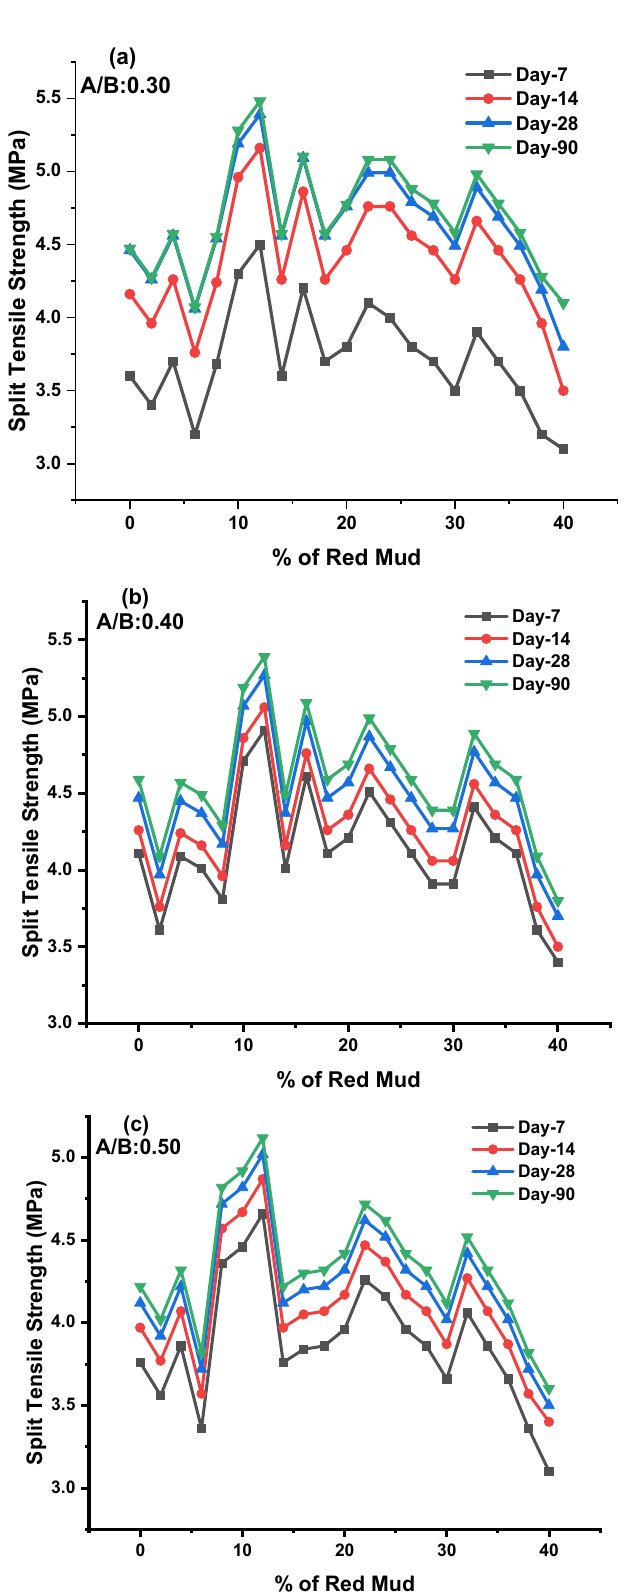
Figure 7. ( a – c ) These represent the STS results for 7, 14, 28, and 90 days for A/B ratio of 0.3, 0.4, and 0.5 for various mixes of GPC, respectively.